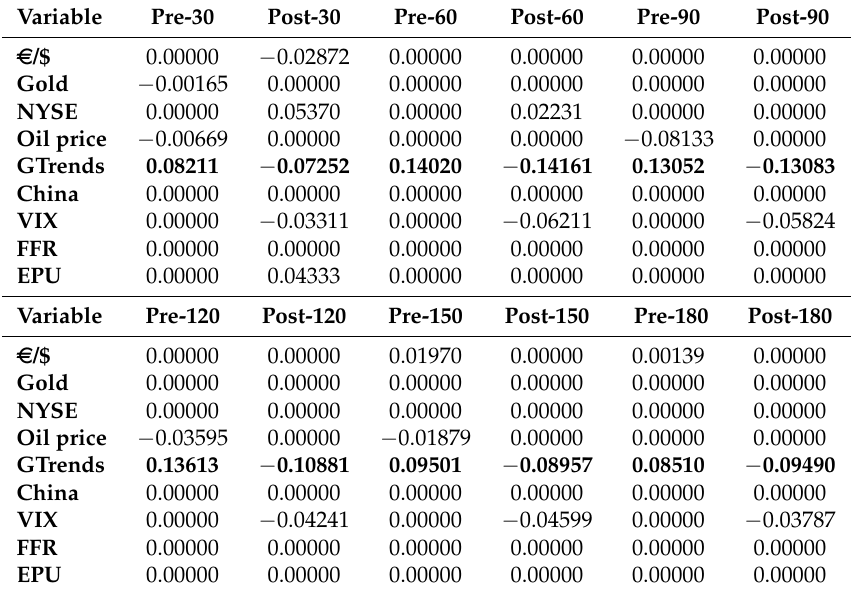
Table 3. Principal component-guided sparse regression (PC-LASSO) coefficients for